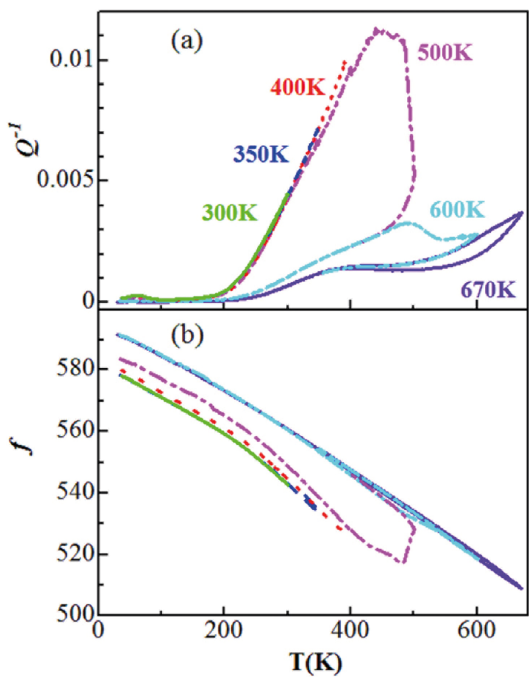
Figure 4. (a) Internal friction ( Q -1 ) and (b) resonant frequency ( f ) spectra of n -Ag during warm-up